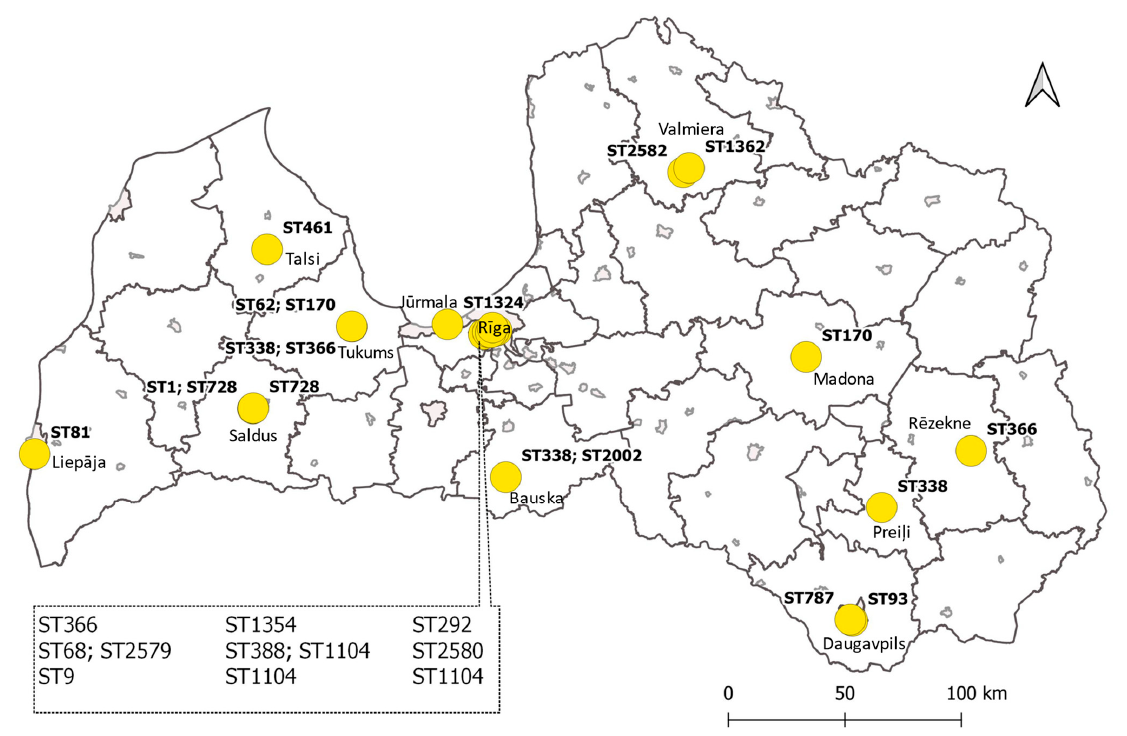
Figure 2. Geographical distribution of L. pneumophila sequence types in Latvia. A minimum spanning tree was constructed with 21 sequence types with at least six matching alleles, as well as four clonal complexes (Figure 3). All four identified clonal complexes included isolates belonging to different serogroups. The clonal complexes were formed regardless of the sampling geography. Only the clonal complex D was found in two isolates from the same city, while the other clonal complexes included isolates from different cities and towns.